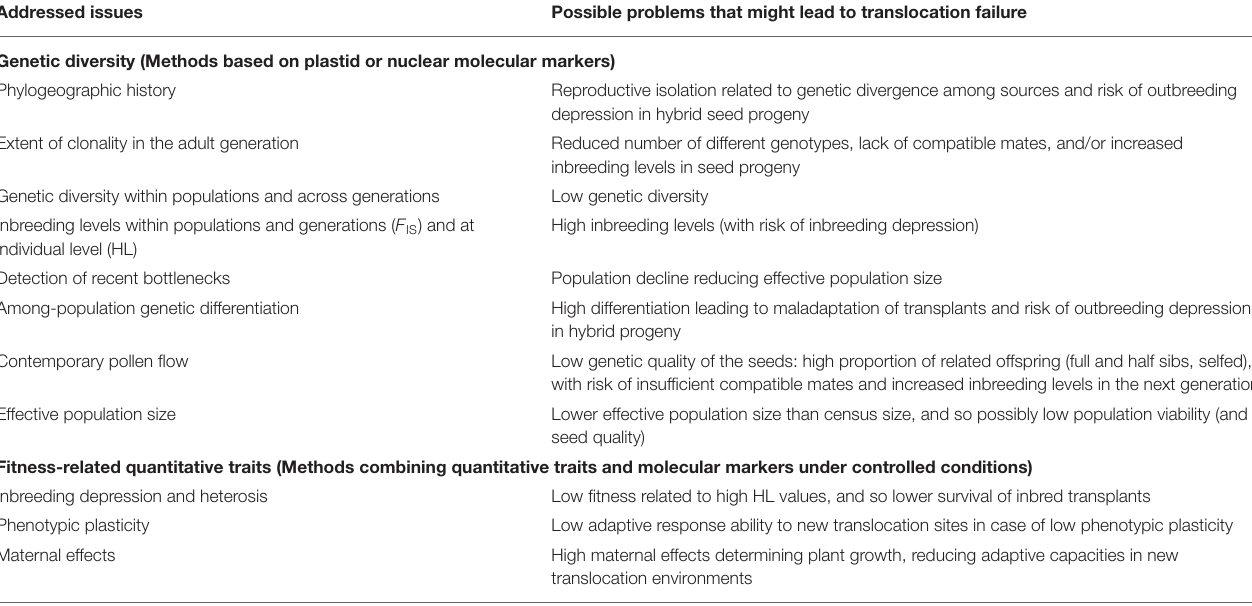
TABLE 1 | Summary of the research questions to investigate and the possible problems that might lead to translocation